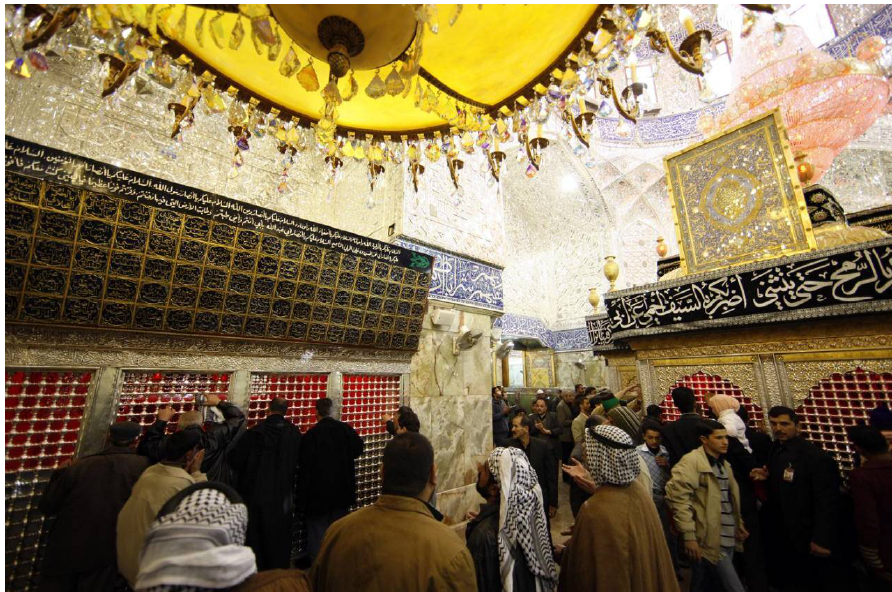
Figure 4. Tomb and grating of the elderly martyr, Habib b. Muzahir al-Asadi. To the right is the grating of Imam al-Husayn, with the narrower grating for his martyred son. To the left is the collective tomb and grating of the Ashura martyrs, with their names inscribed over the metal grating. Source: “Photo Gallery”, ImamHussain.org (n.d.) https://pic.imamhussain.org/gallery/show/1093 accessed on 1 October 2021.